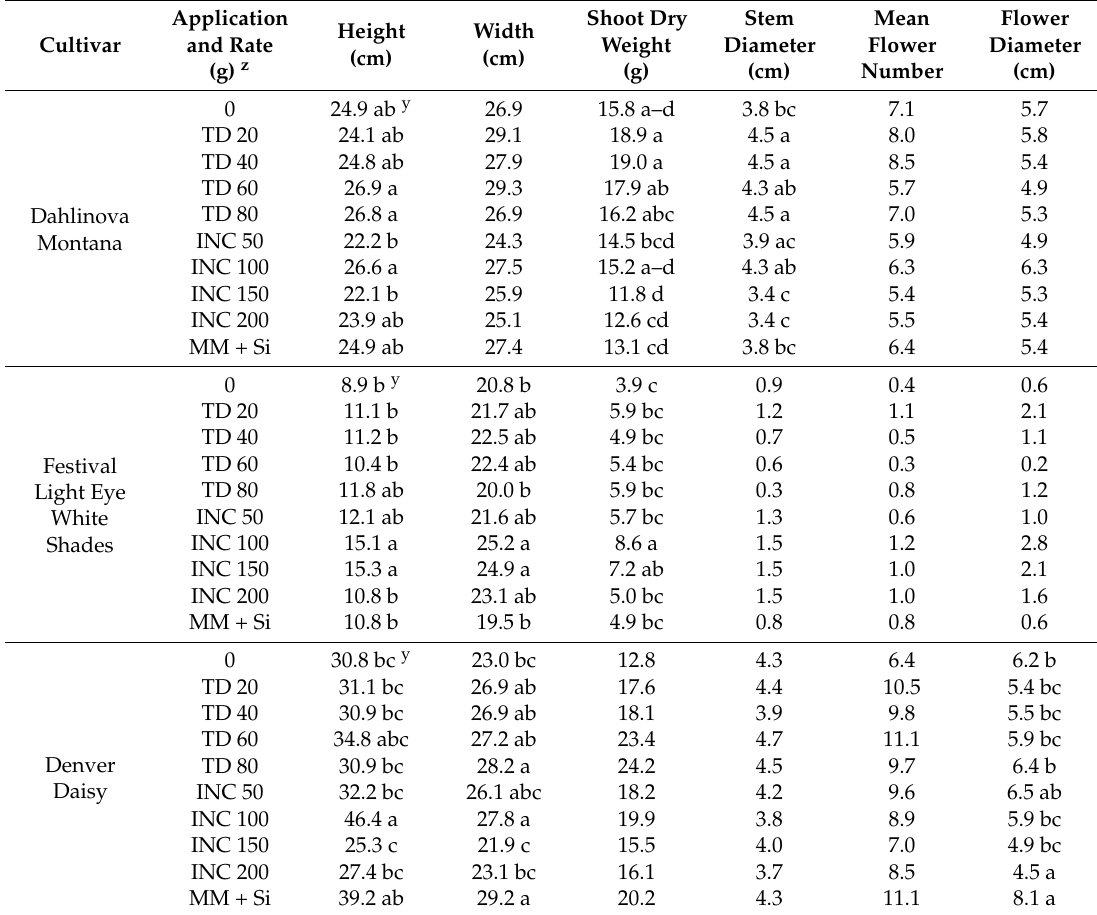
Table 4. Growth and flowering characteristics affected by diatomaceous earth treatment averaged across irrigation, controlled by a tensiometer, in Dahlia × hybrida ‘Dahlinova Montana’, Gerbera jamesonii ‘Festival Light Eye White Shades’, and Rudbeckia hirta ‘Denver